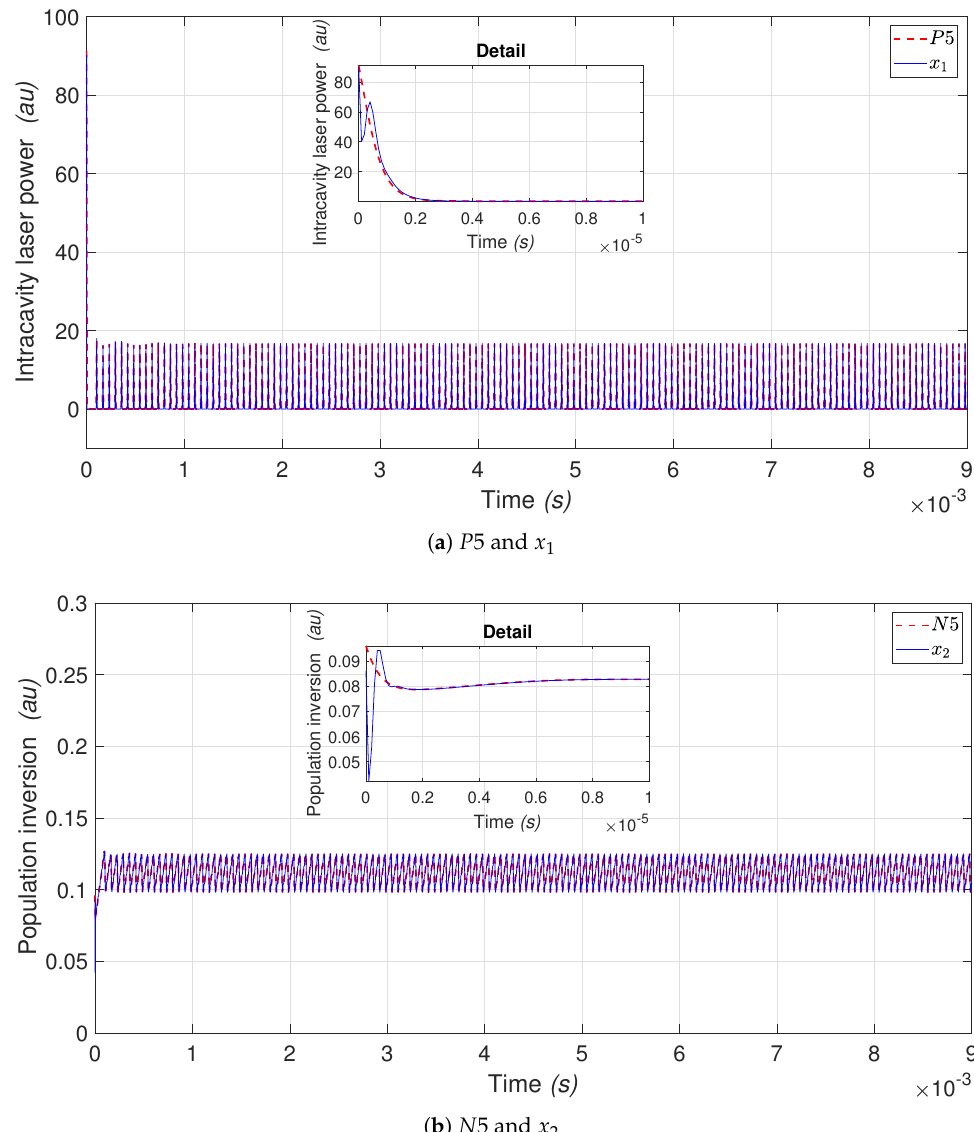
Figure 7. ( a ) Intracavity laser power P 5 and neural identification x 1 behavior. ( b ) Population inversion N 5 and neural identification x 2